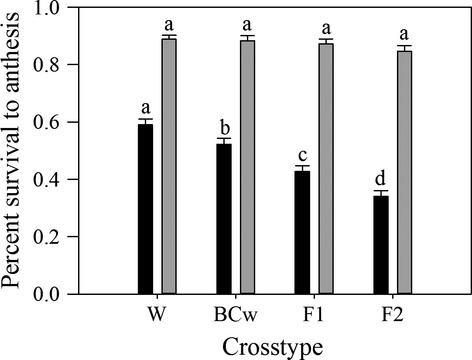
Survival to anthesis for W, BCw, F1, and F2 sunflower crop–wild hybrid cross types from our experiment in Jefferson County, Kansas. Gray bars represent percent survival to anthesis from individuals that emerged in the spring (n = 2670). Black bars represent probability that a planted seed flowered in the first year and was calculated from all seed sown in the fall (n = 4805). Values are means + 1 SE. Cross-types that are marked with the same letter are not significantly different at the 0.05 level using a Tukey–Kramer adjustment for multiple comparisons.